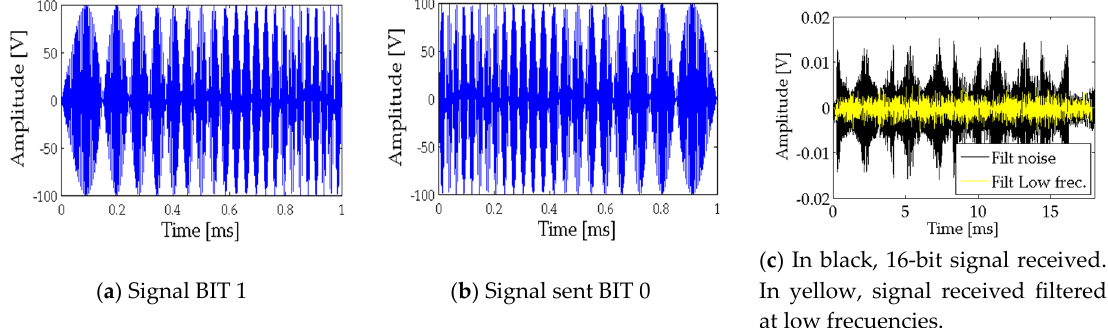
Figure 3. Signal used in the analysis. ( a ) Bit 1: Upwards sweep signal; ( b ) Bit 0: Downwards sweep signal; ( c ) 16-bit received signal and filtered